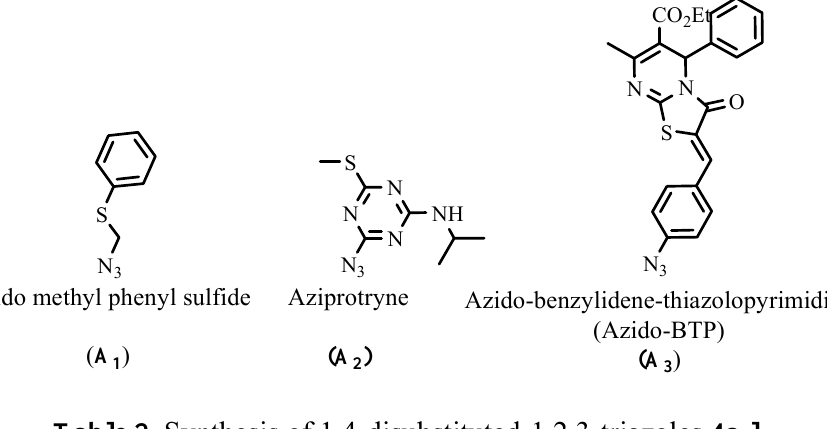
Table 2. Synthesis of 1,4-disubstituted-1,2,3-triazoles 4a-l